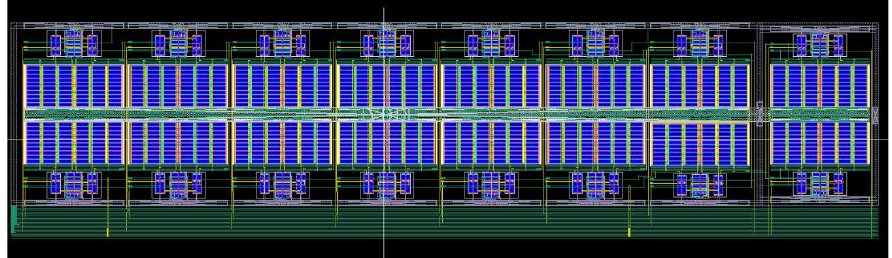
Figure 9. Layout of the implemented fractional-order skin and electrode models (IFLF methodology).